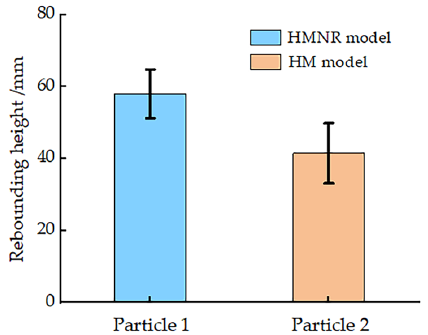
Figure 25. Simulation result for the free drop test with the different contact models.